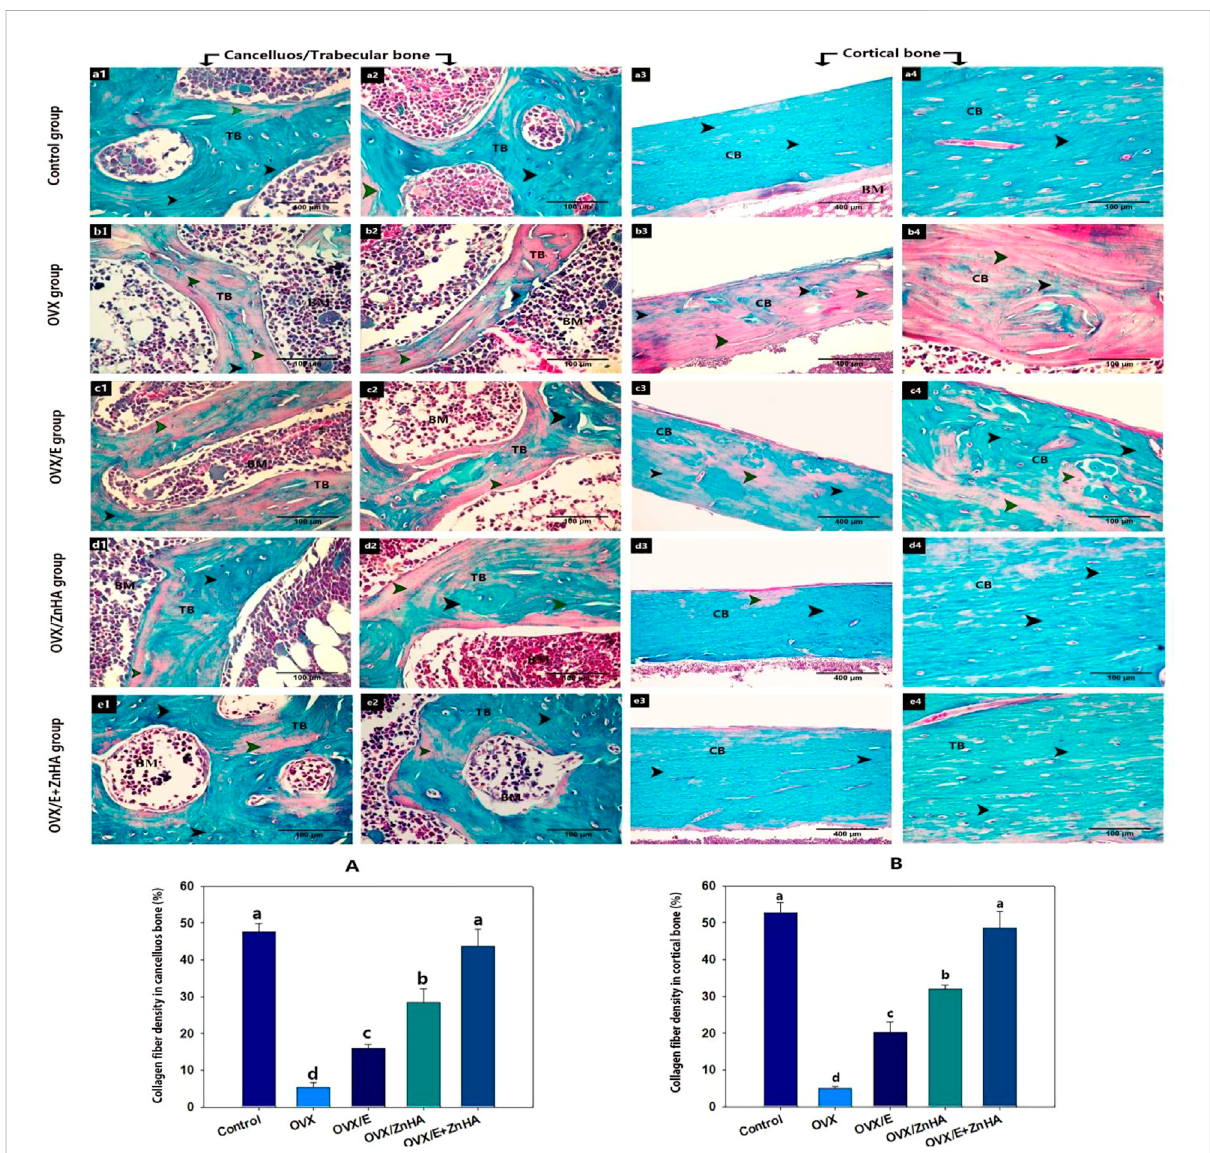
FIGURE 6 PhotomicrographofbonetissuestainedwithMassonTrichromestainfollowingestrogen(E2)and/orzinchydroxyapatitenanoparticles(ZnHA- NPs) in ovariectomized (OVX) rats showing: matrix of the trabecular bone (TB) or cortical bone (CB) with green colored collagen fi bers (black arrowhead) or without green colored collagen fi ber (green arrowhead). (a1,2) trabecular bone and (a3,4) cortical bone of control group. (b1,2) trabecular bone and (b3,4) cortical bone of OVX group. (c1,2) trabecular bone and (c3,4) cortical bone of OVX/E group. (d1,2) trabecular bone and(d3,4)corticalboneofOVX/ZnHAgroup.(e1,2)trabecularboneand(e3,4)corticalboneofOVX/E+ZnHAgroup.Notethegreencoloredareawas widely distributed in control group and OVX/E+ZnHA followed by OVX/ZnHA group then OVX/E group. Histomorphometric analysis (A,B) were expressed as mean ± SME ( n = 5/group, triplicate). Bars carrying different superscripts are signi fi cantly different ( p <